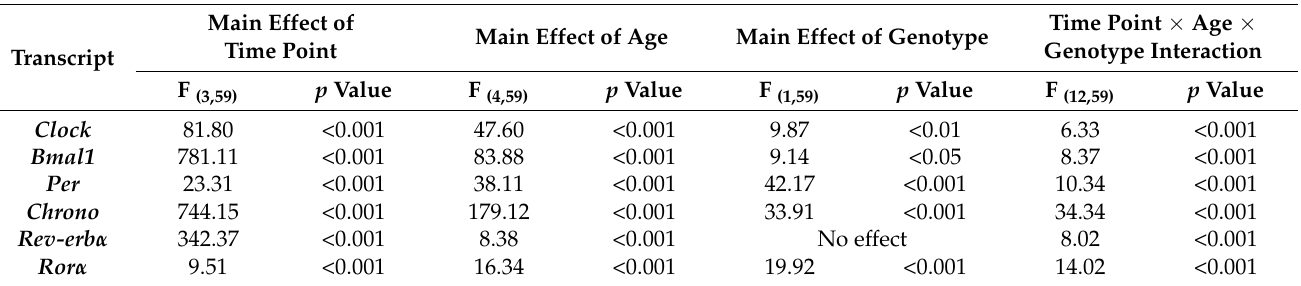
Table 1. Main effect of time point, age, and genotype, and their interaction in Clock , Bmal1 , Per2 , Chrono , Rev-erb α , and Ror α transcripts. The F and p values for the main effect of time point, age, and genotype, and their interaction for each gene were analyzed by Multifactorial-ANOVA. A significant effect was considered when p value <